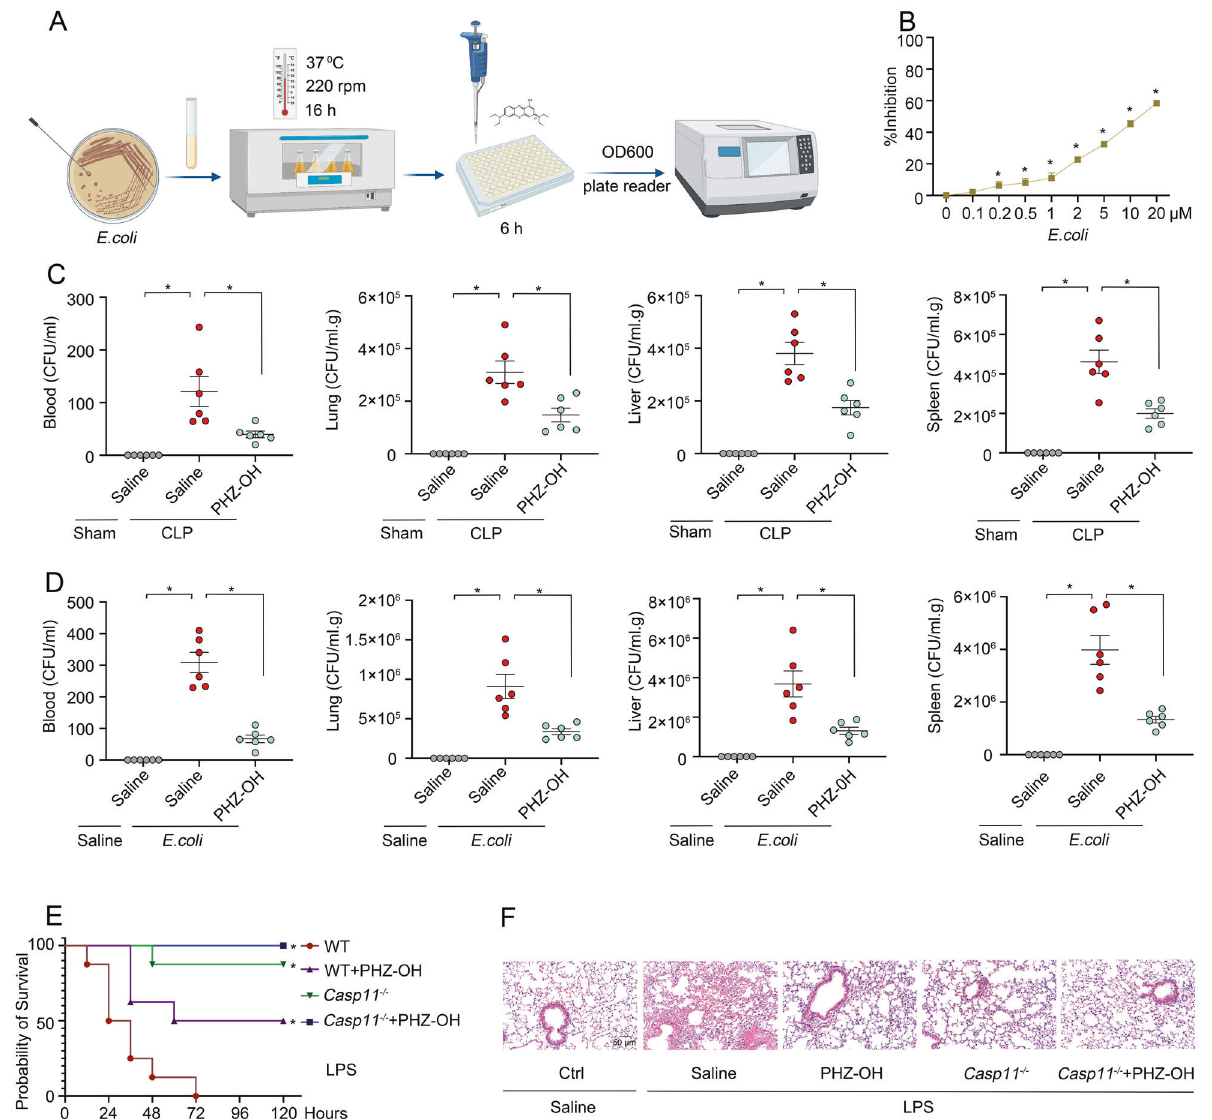
the plasma, the lung, the liver, and the spleen harvested 12 h after the challenge of CLP ( C ) or E. coli ( D ). Mice were treated with saline or 5 mg/kg of PHZ-OH 30 min prior to a challenge of CLP (ligating 75% of the cecal) or E. coli (ATCC 29522, 10 9 CFU per mice); E Survival curves of WT and Casp11 − / − mice treated with saline or PHZ-OH (5 mg/kg) 30 min prior to a challenge of LPS (25 mg/kg); F Lung injury of WT and Casp11 − / − mice treated with saline or PHZ-OH (5 mg/kg) 30 min prior to a challenge of LPS (25 mg/kg) or not for 12 h. Data are mean ± SEM of six mice in one experiment. *P < 0.05. ns, not signi fi cant. Scale bar = 50 μ